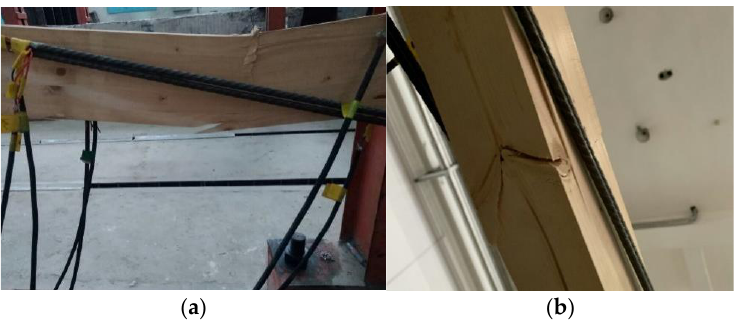
Figure 9. Tensile failure at the beam bottom. ( a ) Fold extension; ( b ) Fracture of the bottom plate.